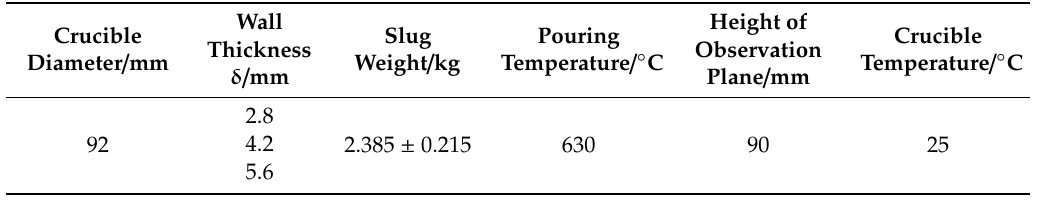
Figure 3. ( a ) Schematic of the crucible used in this study and the cross-sections for the crucible, H is the height of the observation plane, δ is the wall thickness of crucible, ( b ) temperature measuring points with thermocouples, ( c ) microstructure observation locations, named as Center, R / 2 and Edge, respectively. Table 2. The detail information about the crucible and process conditions.